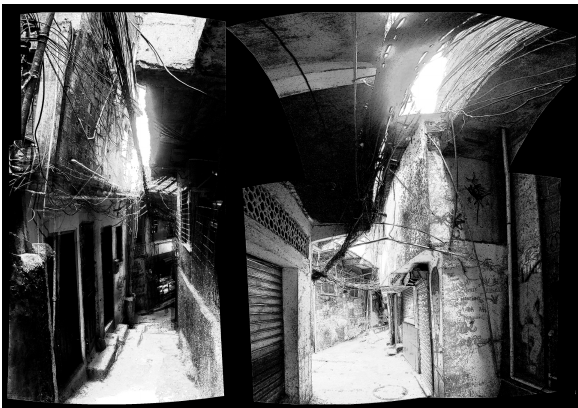
Figure 2. Rocinha becos (alleyways) in the Val˜ao neighbor-